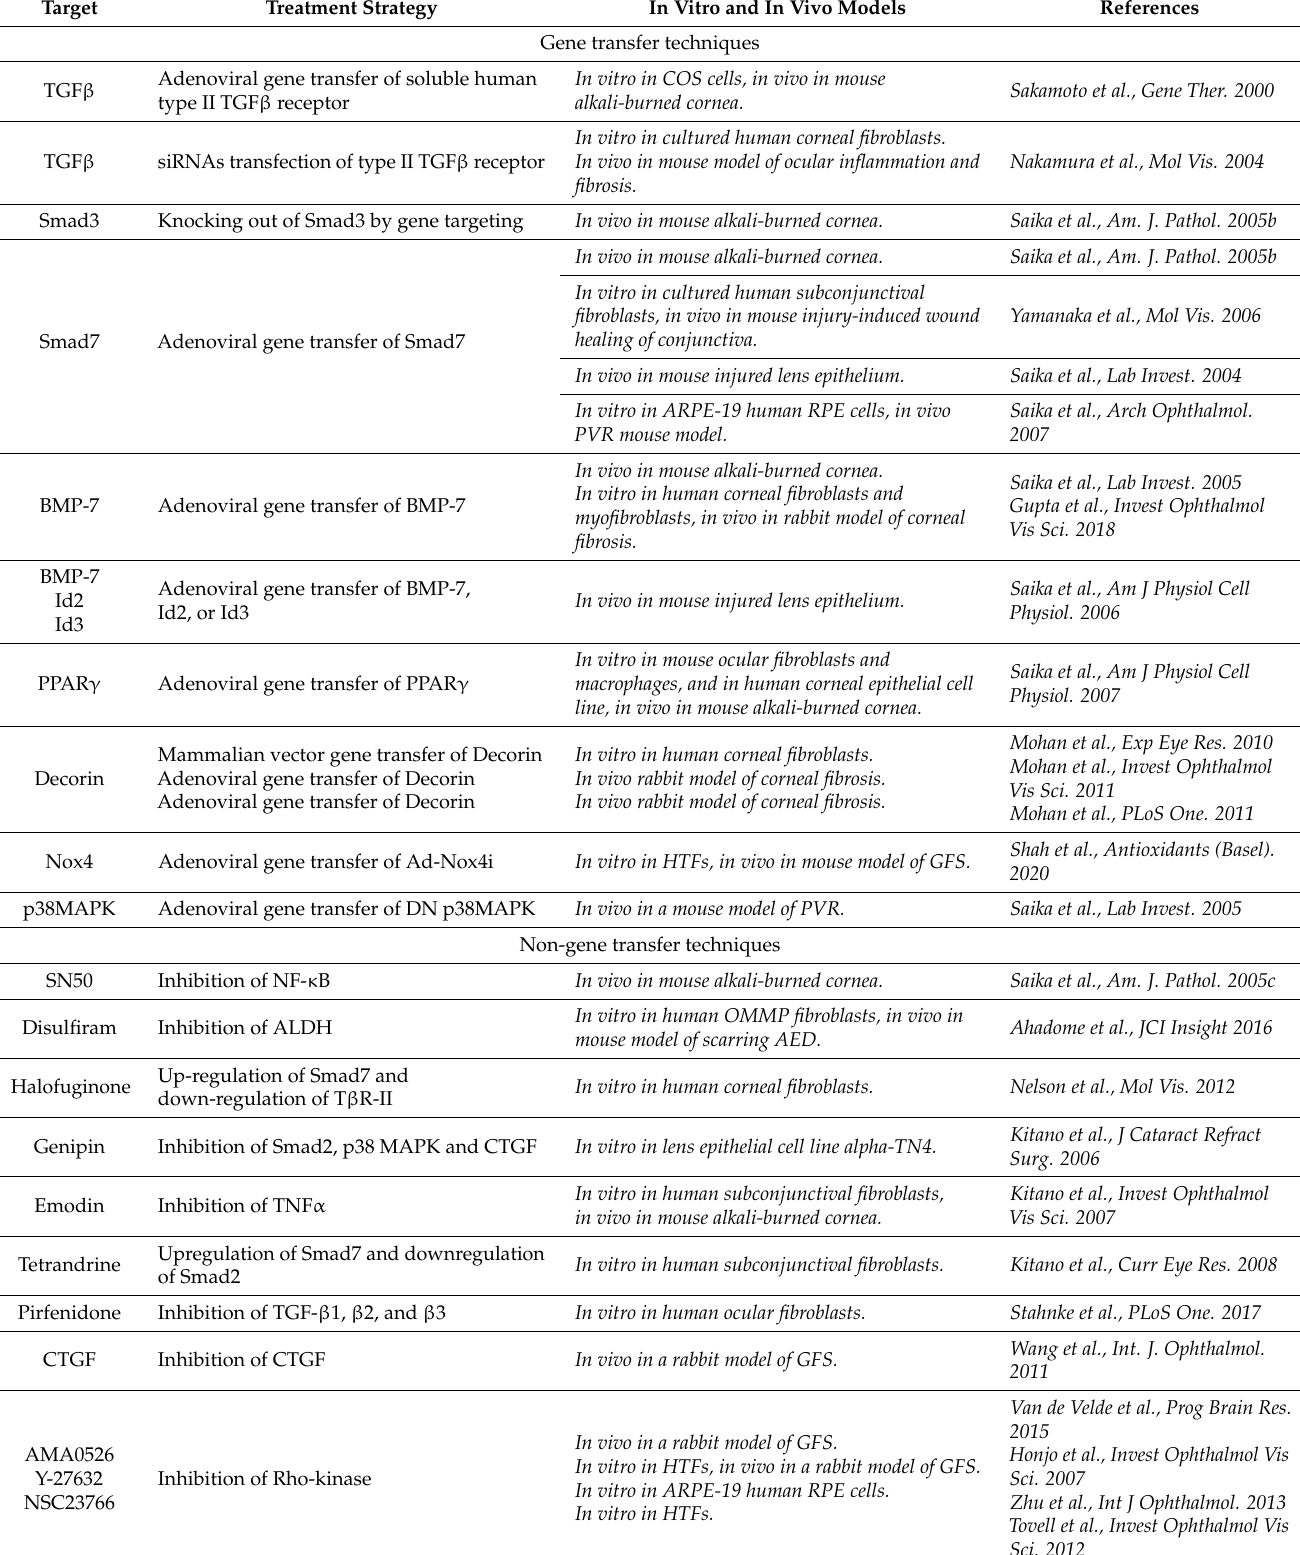
Table 1. Preclinical studies with Gene transfer and non-gene transfer techniques targeting TGF β /Smad in ocular fibrosis.